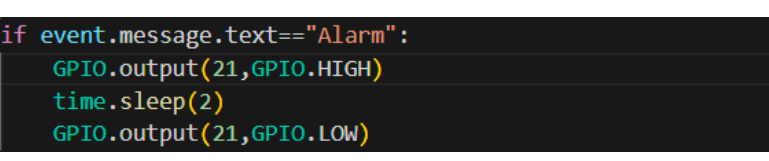
Figure 15. The code corresponds to the “Alarm” message.